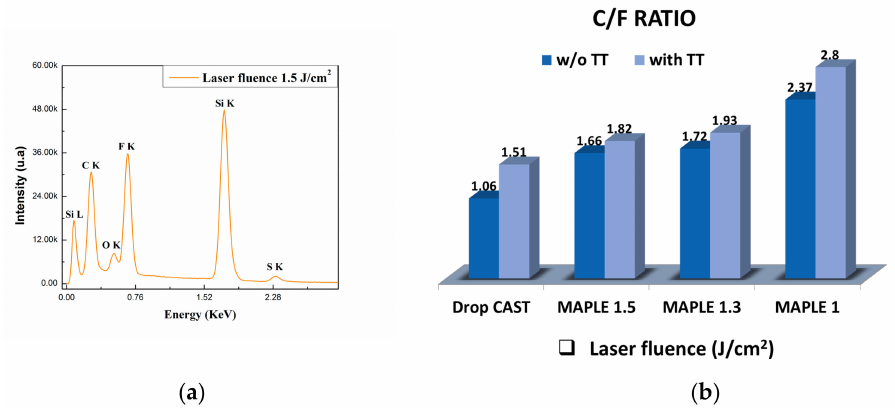
Figure 2. ( a ) Energy Dispersive X-Ray Spectroscopy (EDS) spectrum of PVDF thin film deposited by MAPLE at the highest laser fluence (1.5 J / cm 2 ; see Figure 3e). ( b ) Graphic representation of the comparison of the C / F ratio in the PVDF coatings deposited by MAPLE and MAPLE TT at various laser fluences: 1.0, 1.3, and 1.5 J / cm 2